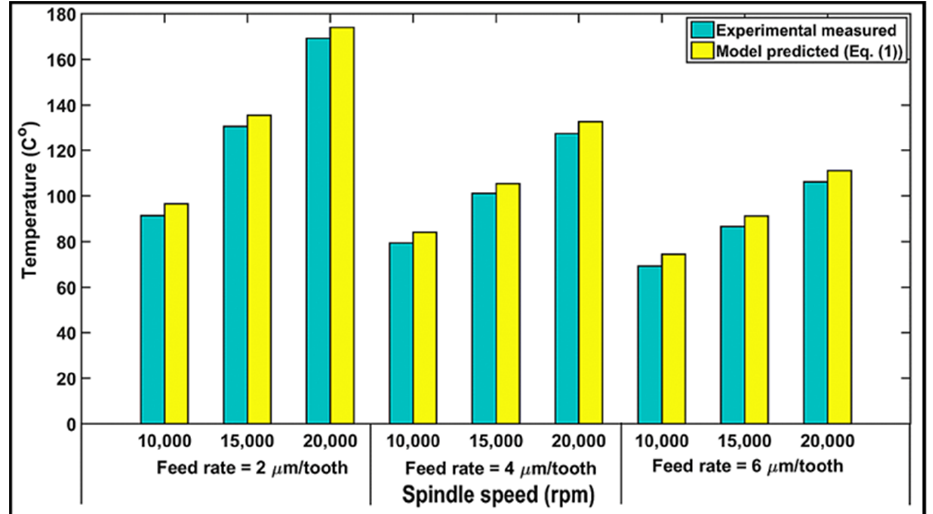
Figure 6. Comparison of measured and predicted temperatures as a function of spindle speeds and feed rates.